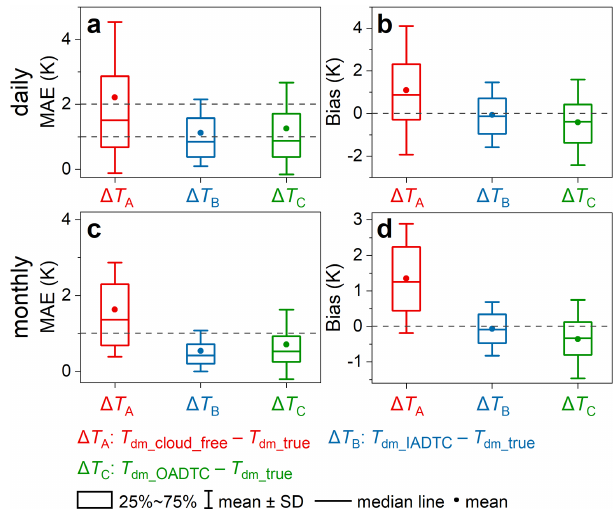
Figure 7. The same as Fig. 6 but for the FLUXNET data.